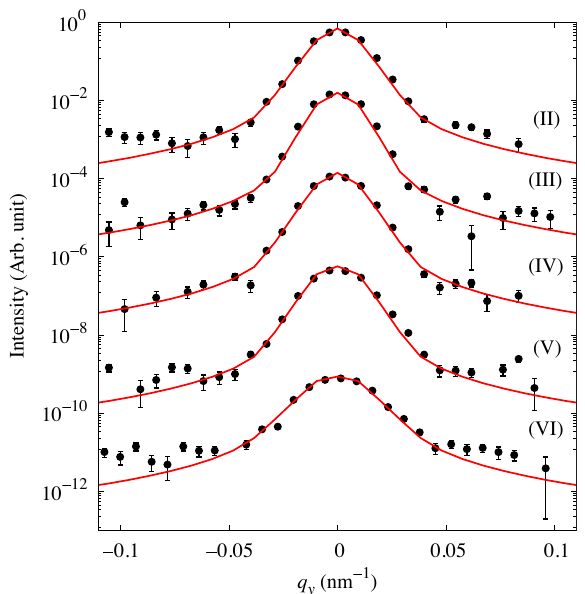
Figure 7. Measured (plots) and simulated (lines) GISANS profiles where the intensity was summed in the α f direction between the broken lines (2.3 ◦ ≤ α f ≤ 2.7 ◦ ) in Figure 6. (II)–(VI) correspond to the measured conditions shown in Figure 2. Each profile is shifted vertically by two orders of magnitude relative to the profile for the immediately previous field for